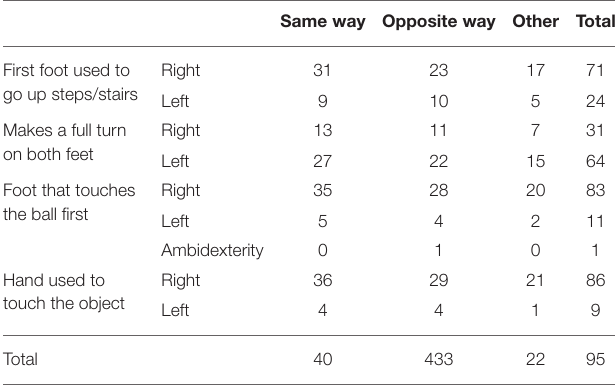
TABLE 10 | Contingency table of spatial orientation strategies used after the first step. Same way Opposite way Other